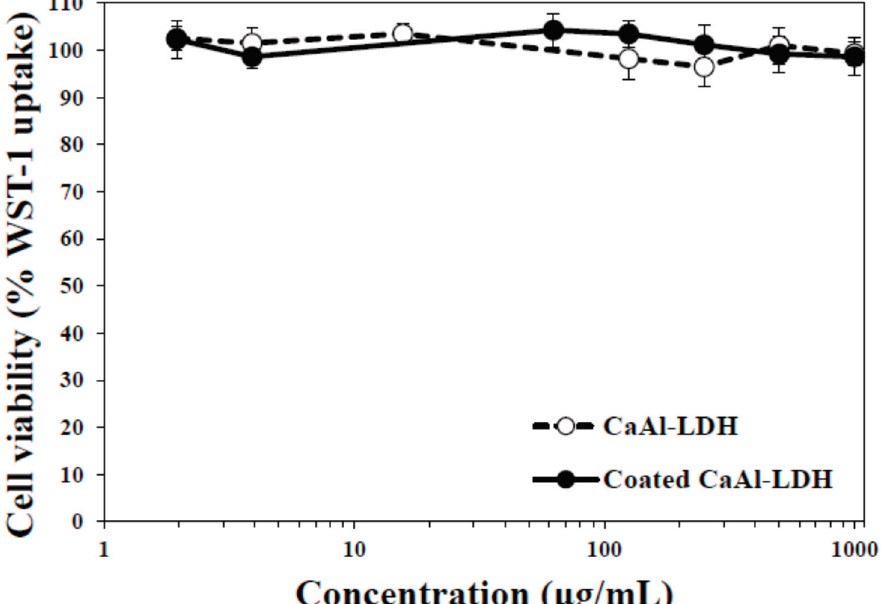
Figure 5. Cell viability of CaAl-LDH treated CaCo-2 cells after 72 h incubation, measured by water-soluble tetrazolium (WST)-1